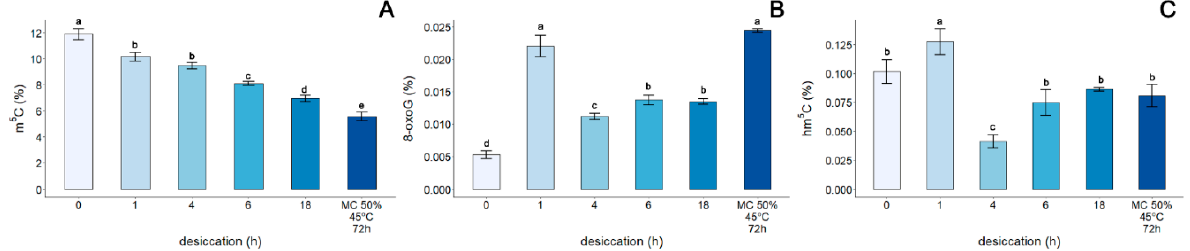
Figure 4. Influence of gradual desiccation and accelerated aging conditions (72 h, 45 °C, MC of 50%) Figure on the relative global level of ( A ) 5-methylcytosine; ( B ) 8-oxo-7,8-dihydroguanine; ( C ) 5-hy- droxymethycytosine. Values labelled with different letters are significantly different at p ≤ 0.05, ac- cording to the Duncan test. Data represents mean ± SE, n = 3.